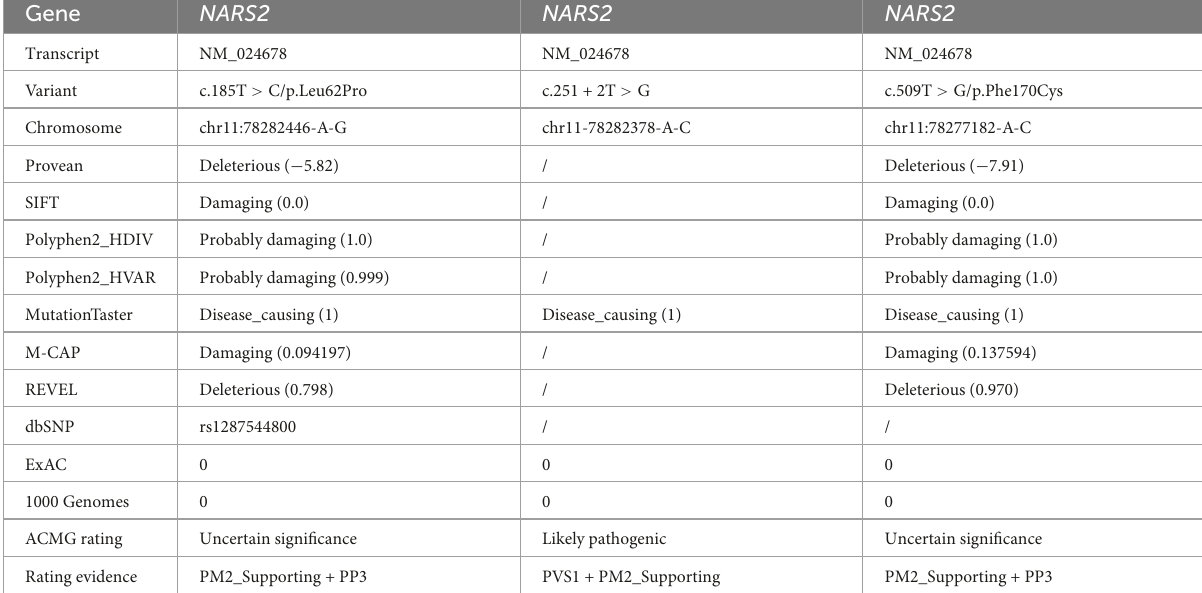
TABLE 2 NARS2 mutation information in this study.